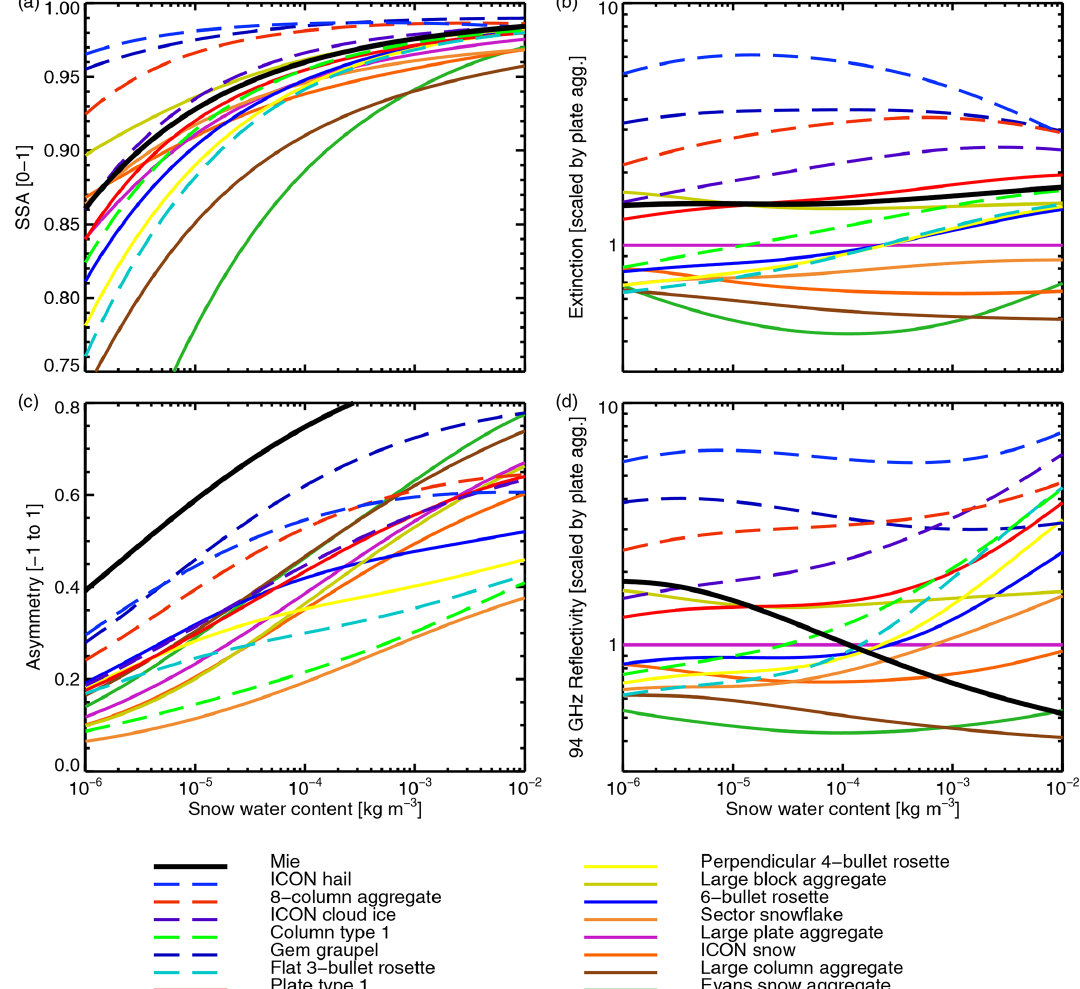
Figure 2. Bulk optical properties for the ARTS frozen particles at 183GHz and 253K, with the exception of panel (d) which gives the reflectivity at 94GHz instead. The Field et al. (2007) tropical PSD has been used in all cases, with the old integration (Sect. 3.2) and a cutoff at D min = 1 × 10 − 4 m. A soft ice sphere (“Mie”) is also included, with settings as in Fig. 1. Bulk reflectivity and extinction have been normalised by those of the ARTS large plate aggregate; some lines are off scale to be able to focus on the most populated areas. The legends are in order of brightness temperature depression at 183 GHz, from most to least scattering (see Fig.